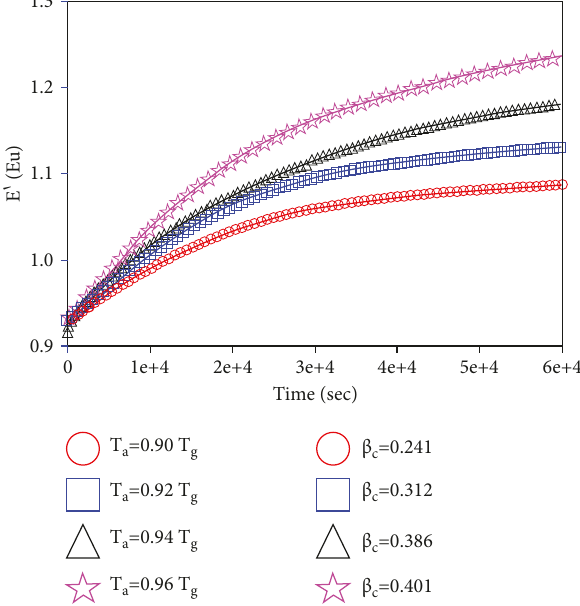
Figure 4: Normalized E ′ as a function of aging time under the driving frequency of 1Hz for ZrCoAlNi